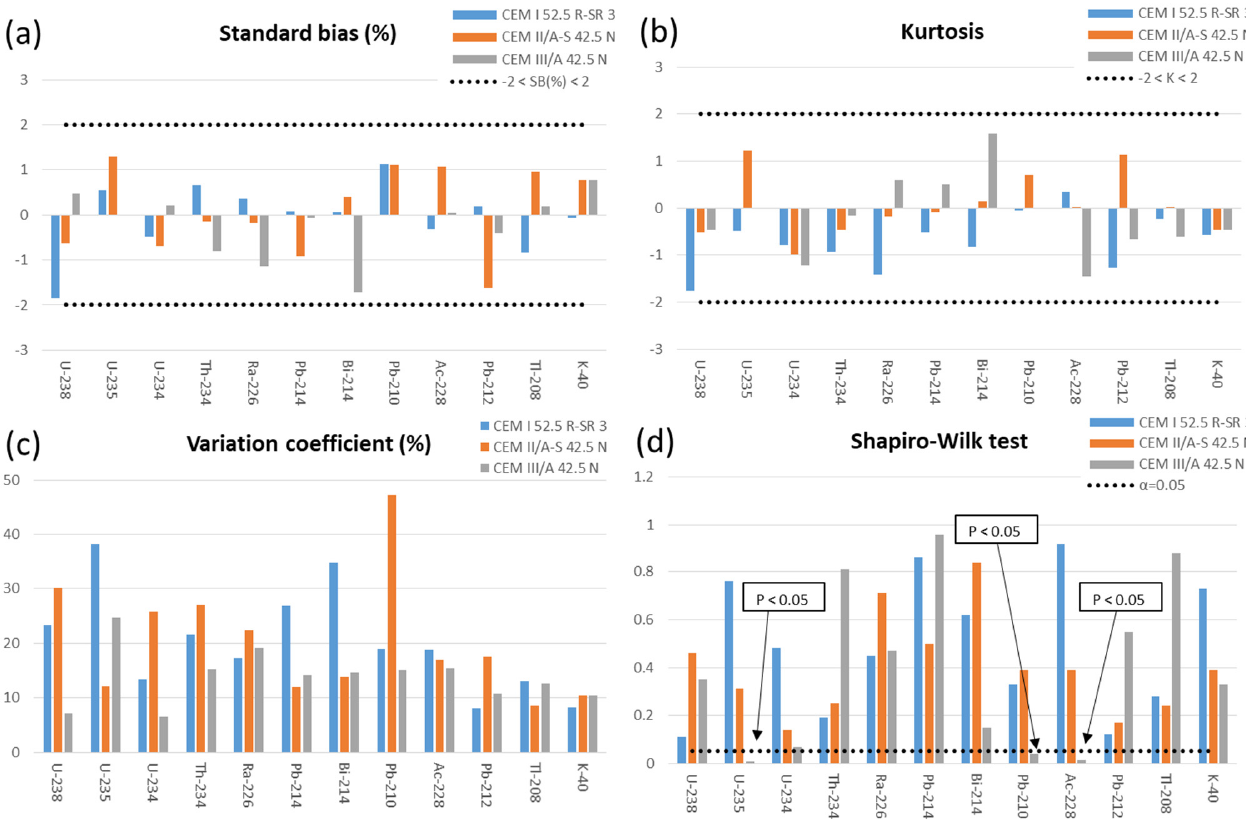
Figure 1. ( a , b ) Results of the evaluation of the mean (Student’s t -test) and variance (Fisher’s F-test) between the solid and ground mortars.